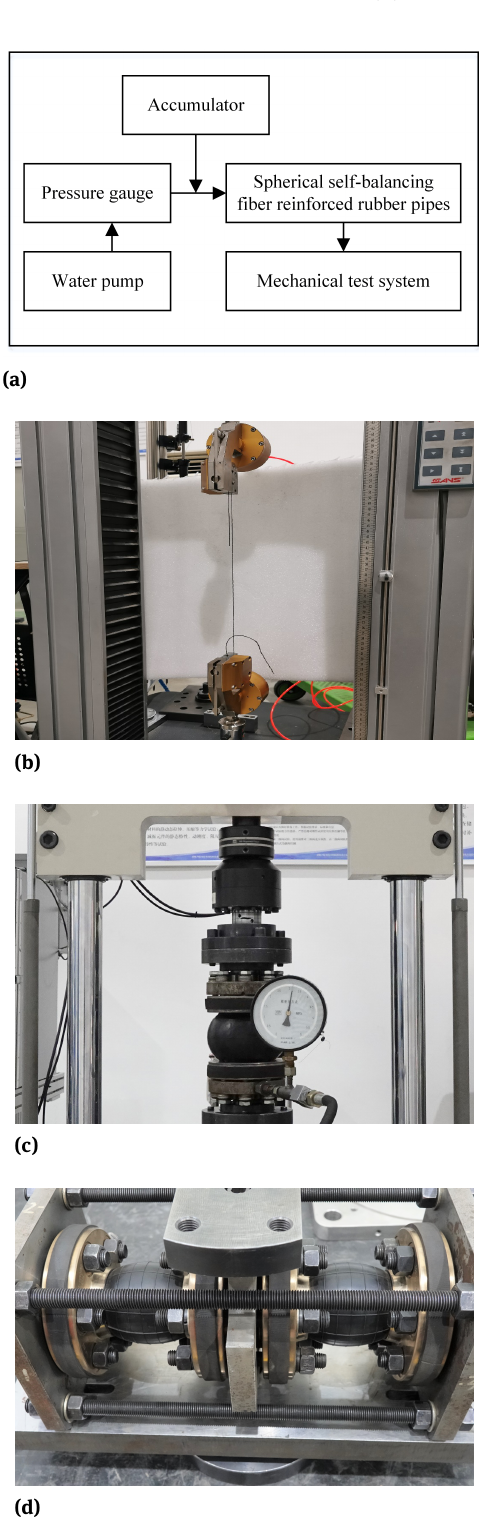
Figure 11: (a) Experimental systems used to measure the axial and lateral stiffness; (b) tensile test of aramid cords; (c) axial stiffness test; (d) lateral stiffness